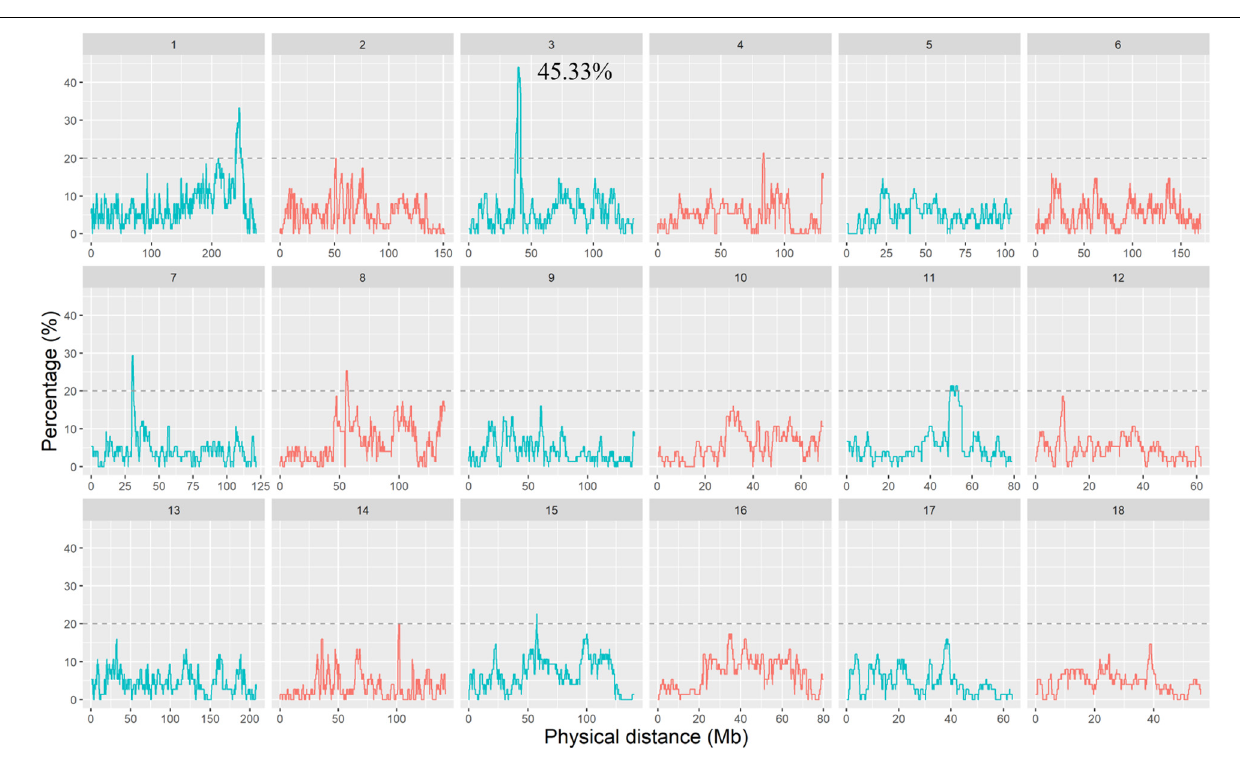
FIGURE 3 | The occurrences (%) of an SNP in ROHs within DSE population. The dashed line indicates the top 0.5% threshold, which defines ROH